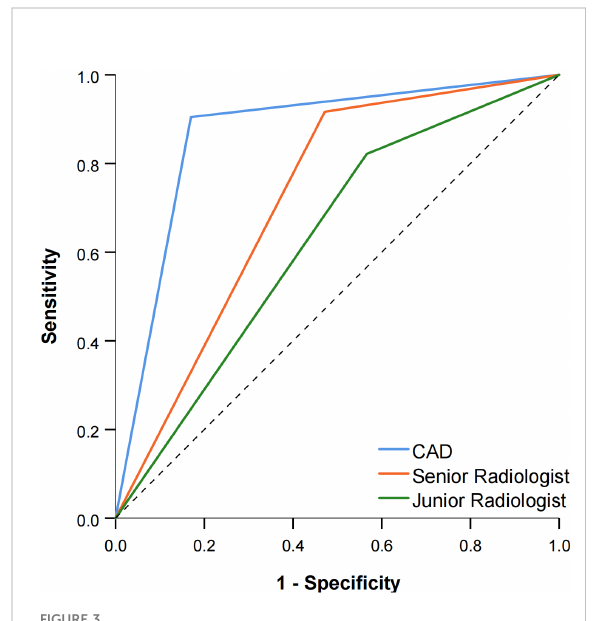
FIGURE 3 Comparison of the ROC curves between CAD and the two radiologists when TR4 was used as the cutoff value.